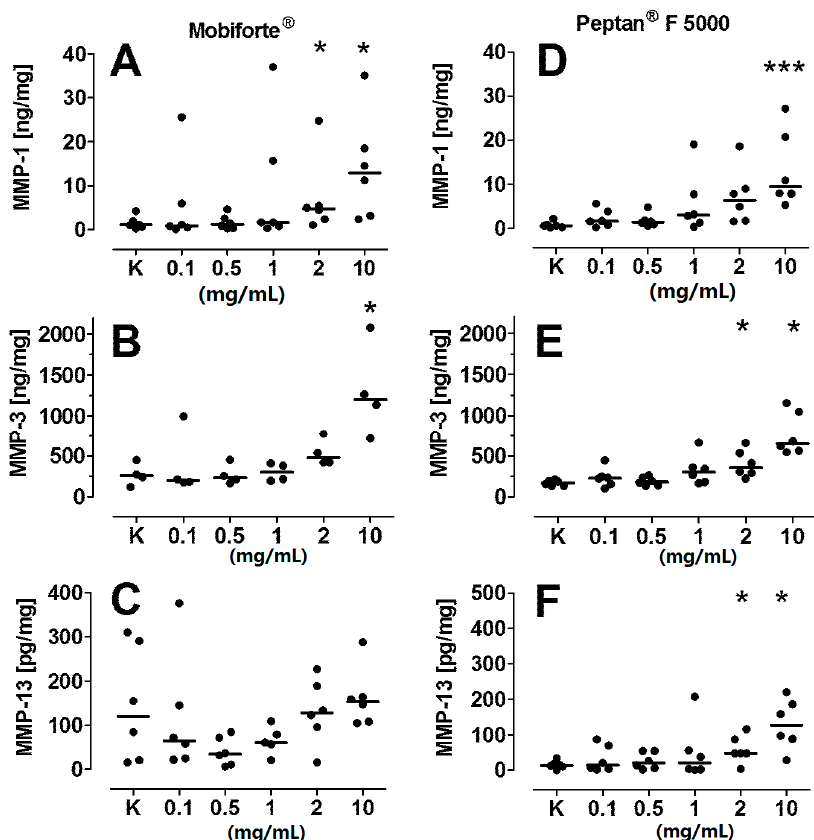
Figure 6. Concentration-dependent effects of CHs on the levels of MMP-1, MMP-3 and MMP-13. MMPs were determined within nutrient media of cultured human articular cartilage explants. Following stabilization of explant metabolism for 4–6 days, explants were treated for an additional six days with 0–10 mg/mL CH. MMP-1 ( A , D ); MMP-3 ( B , E ); and MMP-13 ( C , F ) were measured by ELISA, and data are shown as dot plots with their median ( n = 6). Significant differences between treated and untreated controls (100%) were defined with p -values as follows: * 0.01 < p ≤ 0.05, *** p ≤ 0.001.